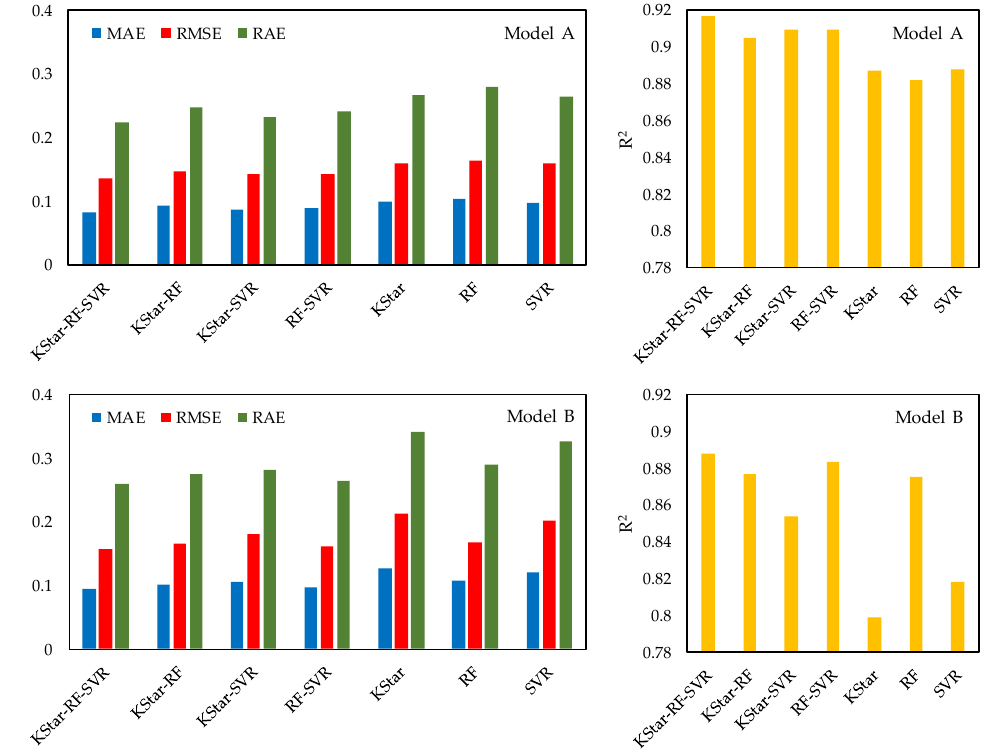
Figure 5. Error histograms (left) and coefficients of determination (right).